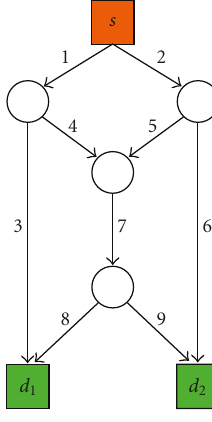
Figure 1: Network topology.